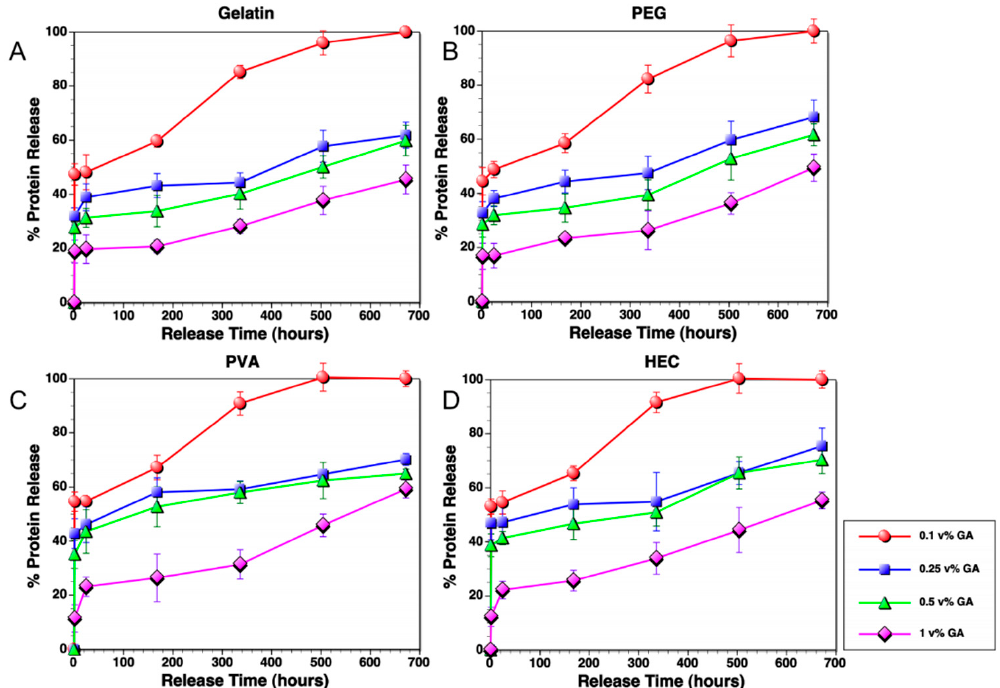
Figure 4. Release of protein from different IPNFs ( A ) gelatin film pellet; ( B ) PEG-enhanced IPNF; ( C ) HEC-enhanced IPNF; and ( D ) PVA-enhanced IPNF in PBS solution (pH 7.4) at 37 °C after cross-linking with different GA volume concentrations (red: 0.1 vol % GA, blue: 0.25 vol % GA, green: 0.5 vol % GA, purple: 1 vol % GA).